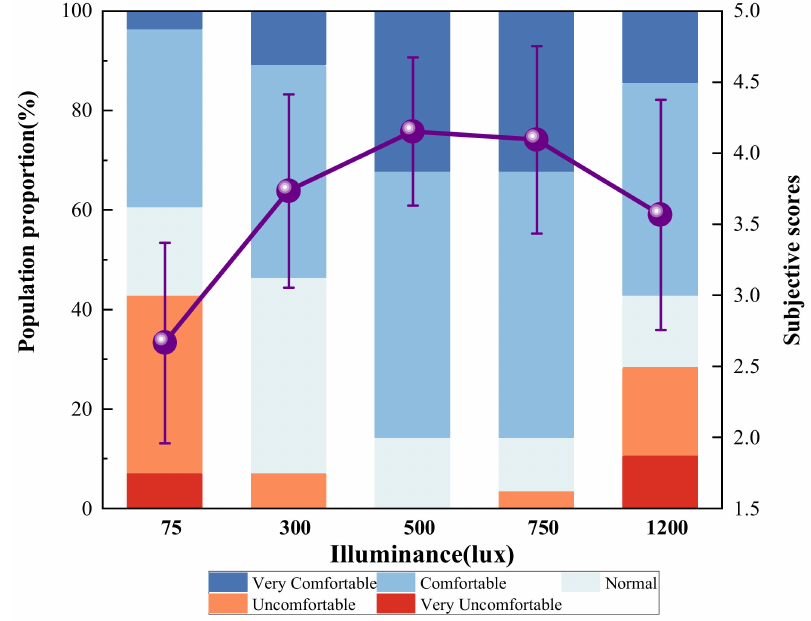
Figure 10. Proportion of subjective evaluation population and scoring.